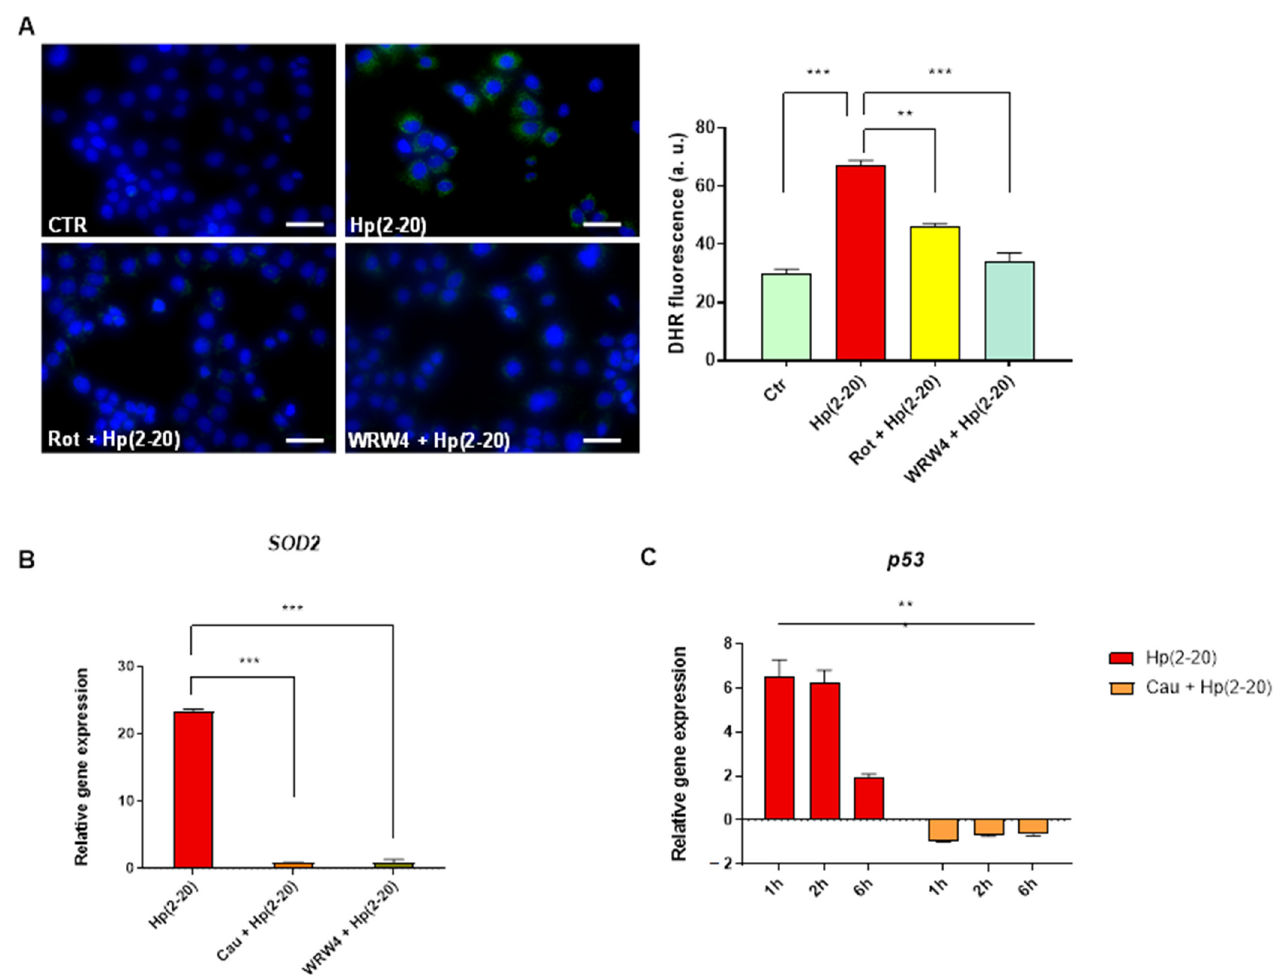
Figure 6. Cau reverses Hp(2–20)-induced ROS produced by mitochondria. ( A ) DHR-loaded cells differently treated: (1) control cells; (2) Hp(2–20) 100 µ M for 1 h; (3) Rotenone 0.5 mM for 15 min and Hp(2–20) 100 µ M for 1 h; (4) WRW4 10 µ M for 15 min and Hp(2–20) 100 µ M for 1 h, observed with a fluorescence microscope (on the left, scale bar: 100 µ m) and quantification of the mean fluorescence of individual cells (on the right). Results are expressed as arbitrary units and represent the average ± SD calculated from three independent experiments each performed in duplicate. Statistical analysis was performed by GraphPad Prisma software, using one-way ANOVA. ** p < 0.001; *** p < 0.0001. ( B ) Relative gene expression of SOD2 by quantitative real time PCR (qPCR) in cells treated with: (1) Hp(2–20) 25 µ M for 2 h; (2) Cau 15 µ M for 30 min and then Hp(2–20) 25 µ M for 2 h; (3) WRW4 10 µ M for 15 min and then Hp(2–20) 25 µ M for 2 h. ( C ) Relative gene expression of p53 by quantitative real time PCR (qPCR) in cells treated with (1) Hp(2–20) 25 µ M for 1 h; (2) Hp(2–20) 25 µ M for 2 h; (3) Hp(2–20) 25 µ M for 6 h; (4) Cau 15 µ M for 30 min and Hp(2–20) 25 µ M for 1 h; (5) Cau 15 µ M for 30 min and Hp(2–20) 25 µ M for 2 h; (6) Cau 15 µ M for 30 min and Hp(2–20) 25 µ M for 6 h. All samples were normalized to GAPDH as